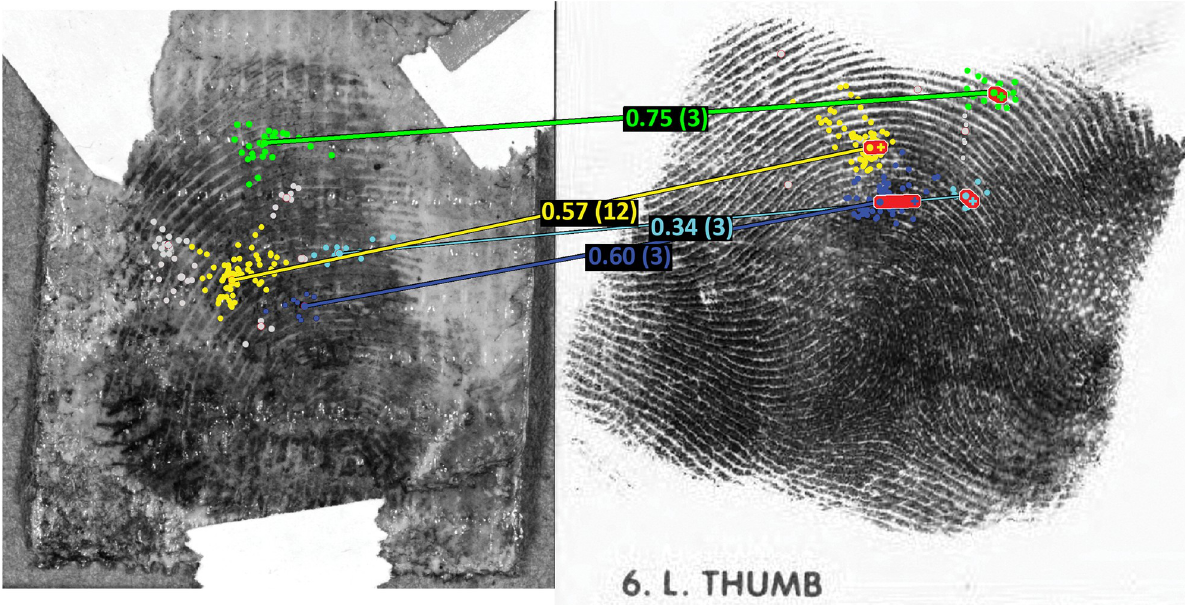
Fig 1. Example spatial clustering of fixations and correspondence attempts estimated by the TECA model. Small colored circles correspond to fixations, while larger circles at line endpoints correspond to the cluster centroids (regions of highest density within the cluster). Colored lines indicate estimated correspondence attempts, and the proportions indicate the strength of each correspondence attempt (see text for details). The short red lines on the exemplar indicate the distance to the projected corresponding location as described in Appendix SI-3.1e in S3 Appendix (e.g., see the short red line on the blue cluster on the exemplar). Note that only fixations from the ‘detail/deciding’ subphase are displayed and used to establish clusters, and some latent clusters are not associated if they did not have direct temporal sequences with clusters on the exemplar (and are plotted in gray). The two prints shown here are mated, and the examiner gave an identification conclusion and rated this as ‘moderately